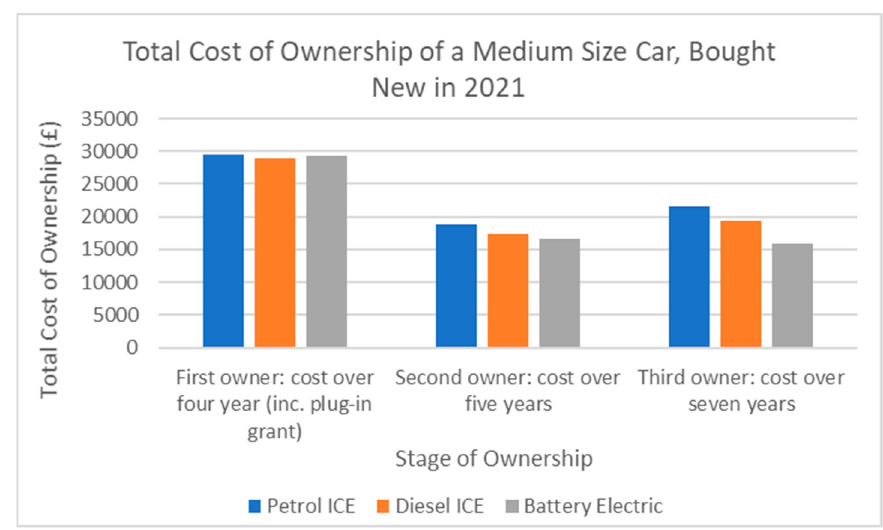
Figure 2. Total cost of ownership comparison for petrol and diesel internal combustion engine (ICE) vehicles and battery electric vehicles (BEVs). Source of data: [27].